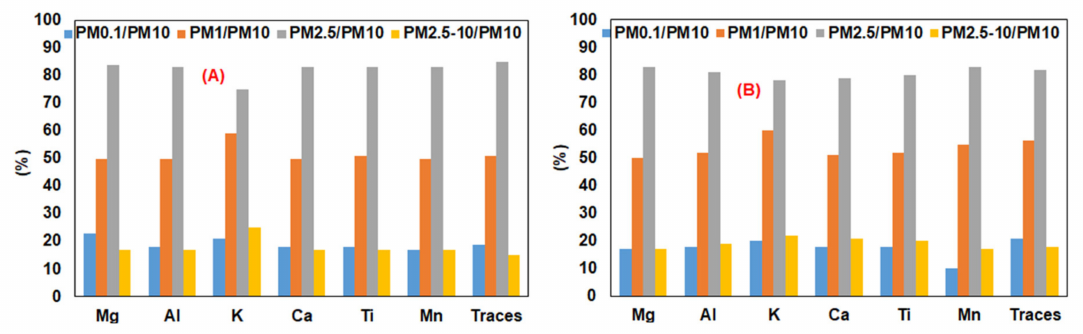
Figure 7. Average elemental distribution in di ff erent indoor ( A ) and outdoor ( B ) particulate fractions (%) sampled during the class at S1 (n = 80, average ±